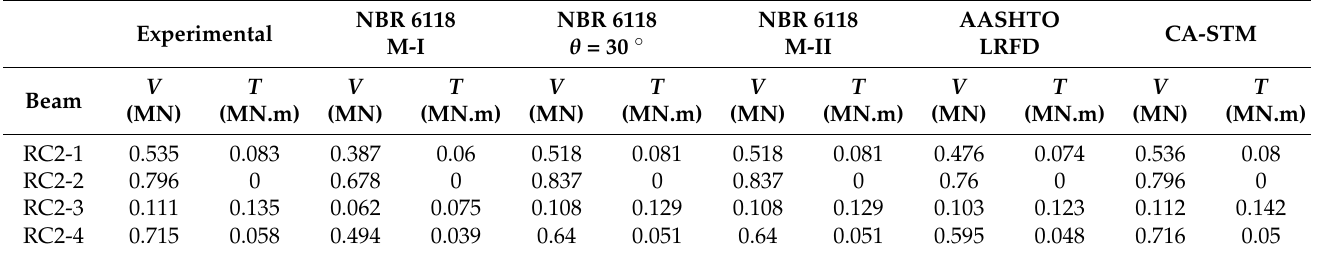
Table 1. Results for RC beams from Series 1.